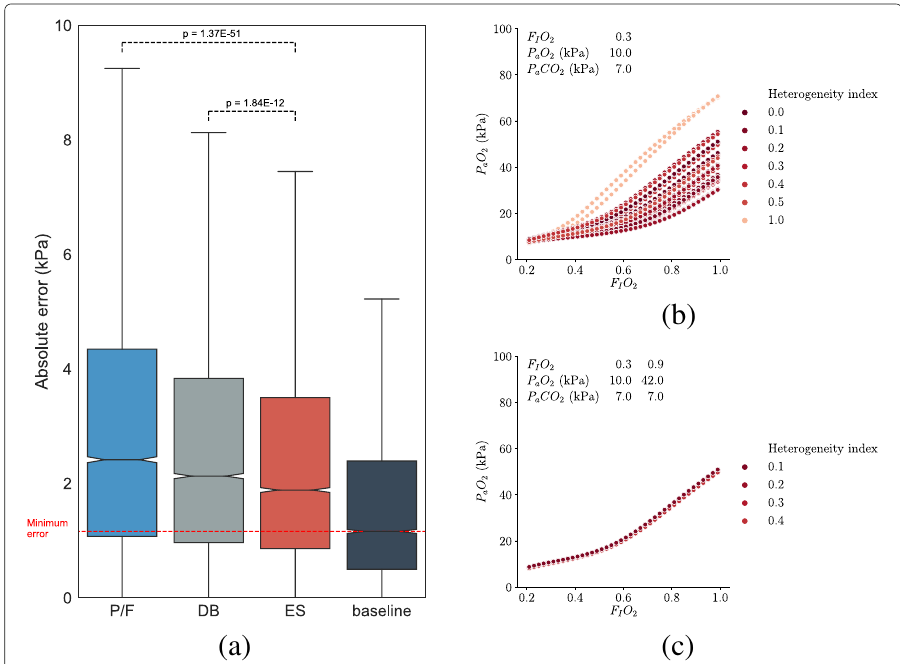
Fig. 1 a Boxplot showing distribution of absolute error for each measure in all samples, together with baseline distribution of pairs of ABGs in which F I O 2 was unchanged (box shows mean +/ − one quartile, whiskers show range). b Range of possible F I O 2 -P a O 2 combinations for conditions matching a single ABG result. c Range of possible results for conditions matching two ABG results at different F I O 2